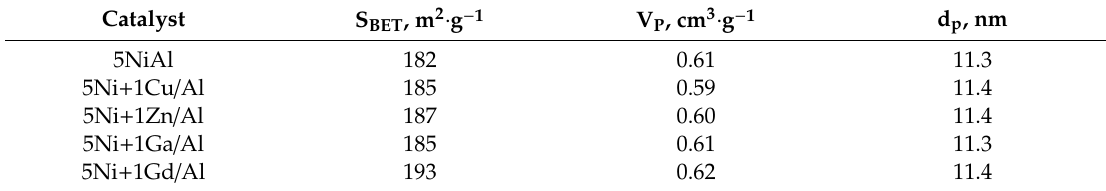
Table 1. Textural properties (S BET , V P , d p ) of the non-promoted and promoted catalysts.